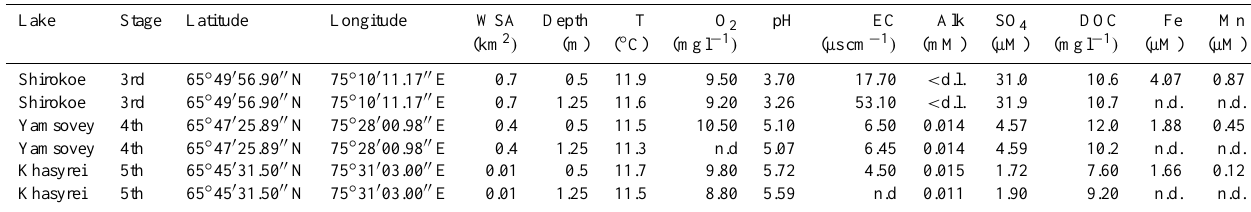
Lake Stage Latitude Longitude WSA Depth T pH EC Alk SO